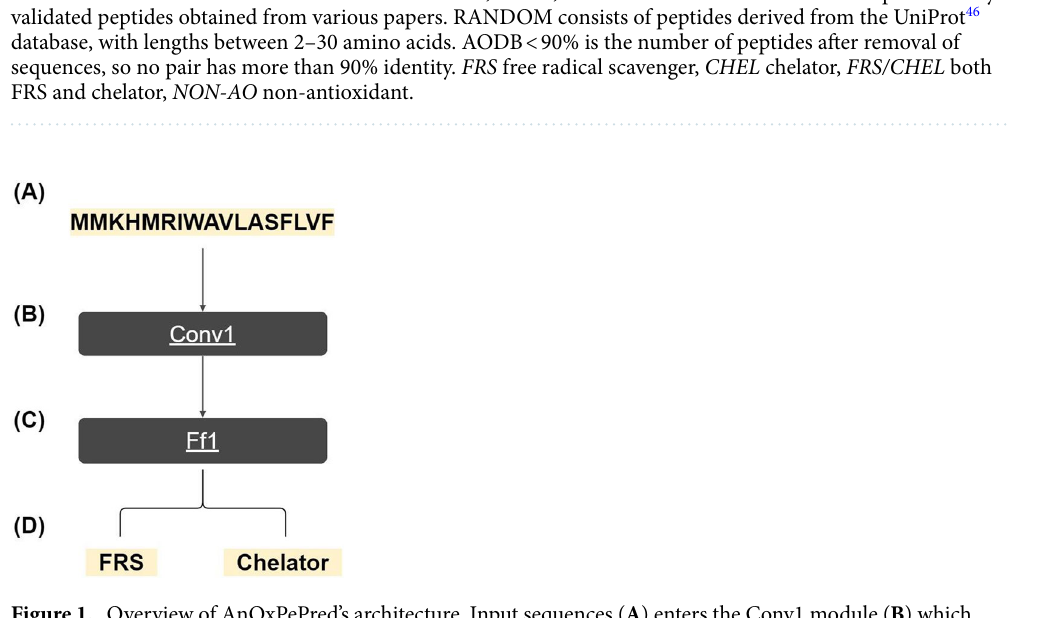
Figure 1. Overview of AnOxPePred’s architecture. Input sequences ( A ) enters the Conv1 module ( B ) which extracts a set of features. The extracted features are then flattened before entering the Ff1 module ( C ). Here the features are used to predict the final output of FRS and chelating properties ( D ). FRS free radical